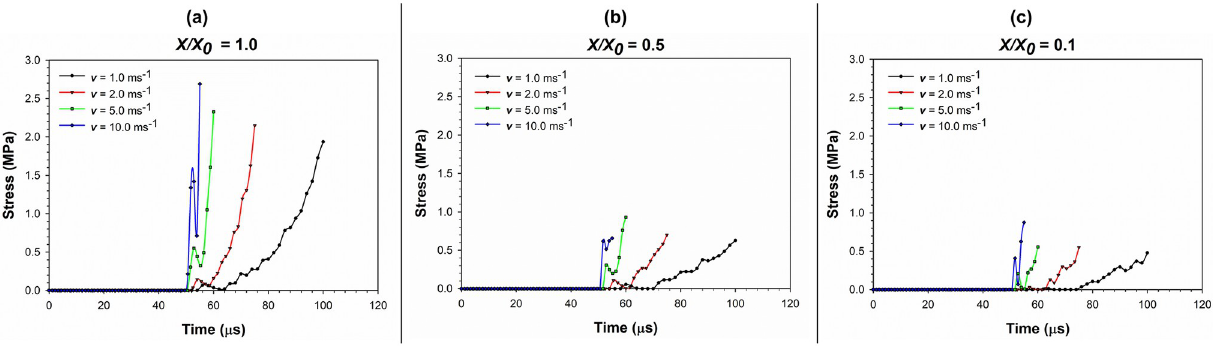
Fig 12. Variation of stress with time during the cell compression simulation as affected by varying compression rates. (a) fresh cells ( X/X 0 = 1.0); (b) moderately dried cells ( X/X = 0.5); (c) extremely dried cells ( X/X 0